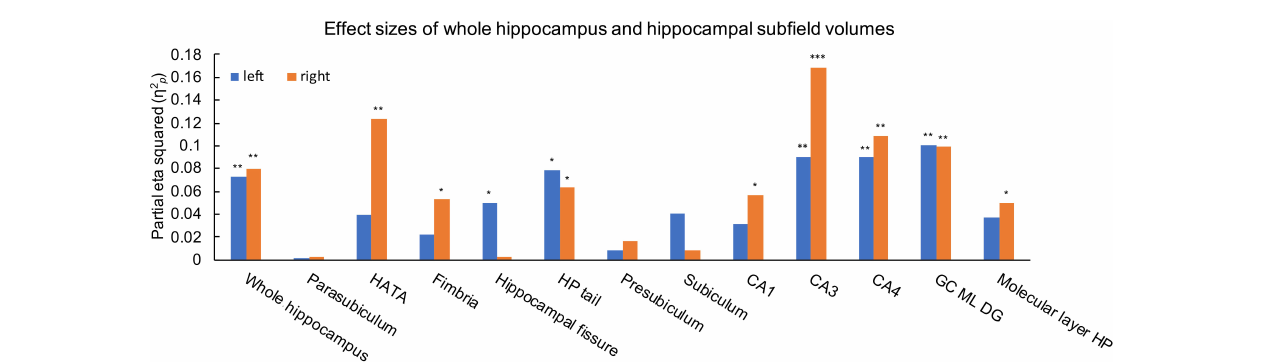
FIGURE4 Effects size estimates measured by partial eta squared ( η 2 p ) for the left (blue) and right (orange) whole hippocampus and hippocampal subfields. η 2 p = 0.01 indicates a small effect; η 2 p = 0.06 indicates a medium effect, and η 2 p = 0.14 indicates a large effect. *** q < 0.001, ** q < 0.01, * q <